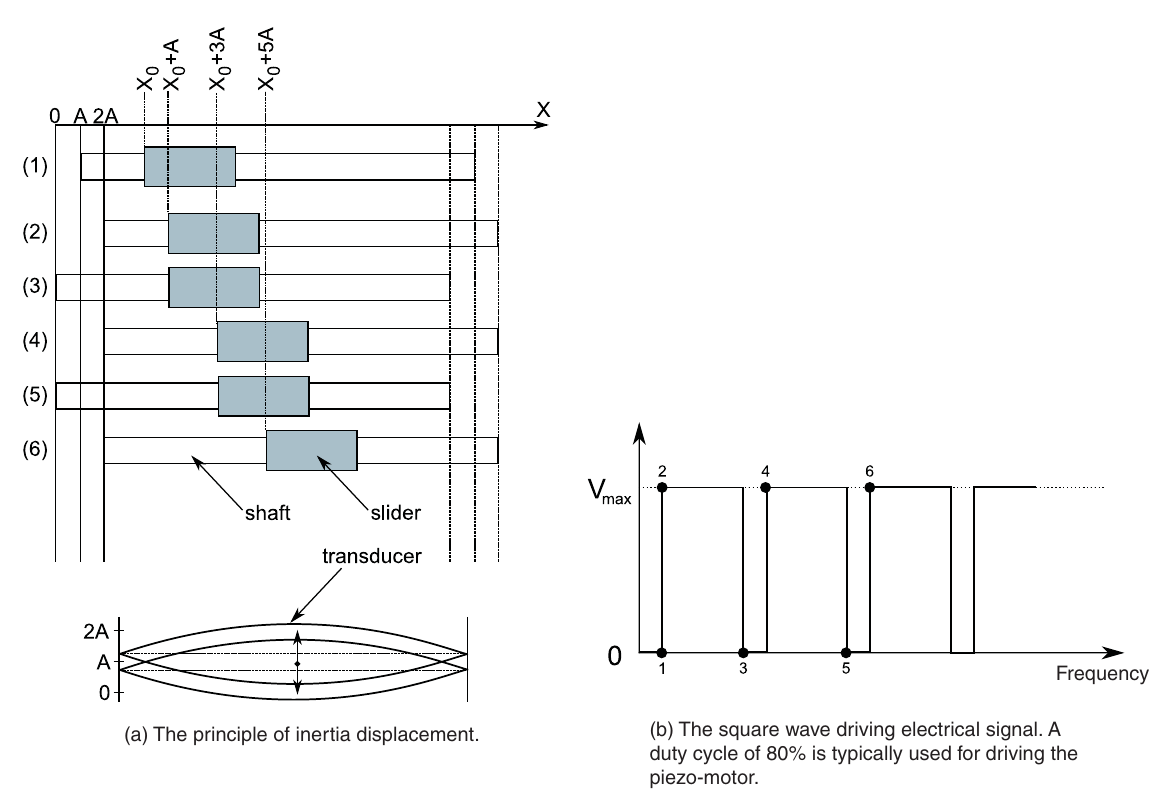
Fig. 6. Operation principle for the piezoelectric ultrasonic linear